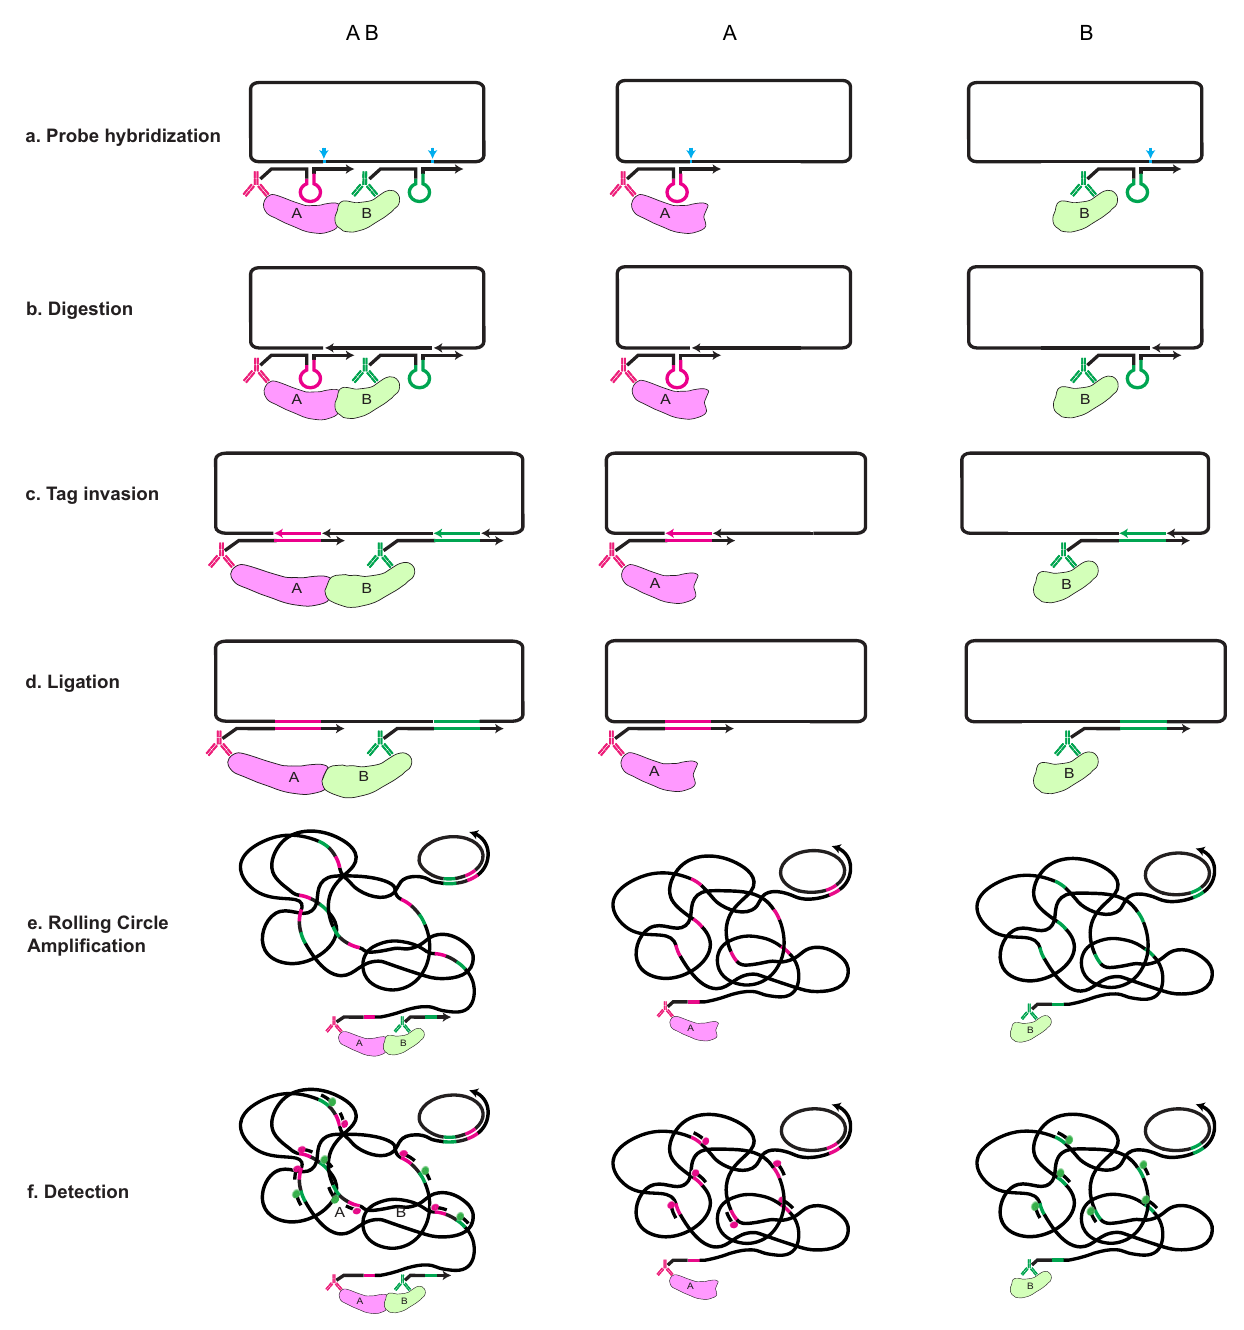
Fig. 1 | Schematic representation of the MolBoolean principle for detection of interacting and free proteins A and B. a After binding their respective target proteins A and B,proximity probes A (blackand magenta) and B (blackand green) hybridize to the circle. Arrows signify oligonucleotide polarity. b The circle gets enzymaticallynicked(cyanarrowhead indicatesnickingposition). c Thecirclegets